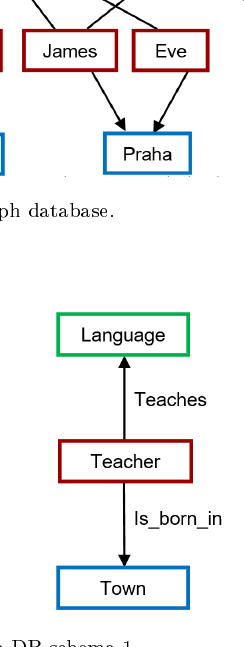
Fig. 2: Graph DB-schema